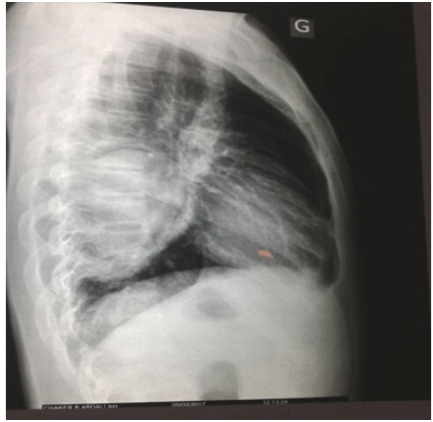
Figure 2: Lateral view chest X-ray showing a well-defined rounded opacity was in the retrocardiac space.